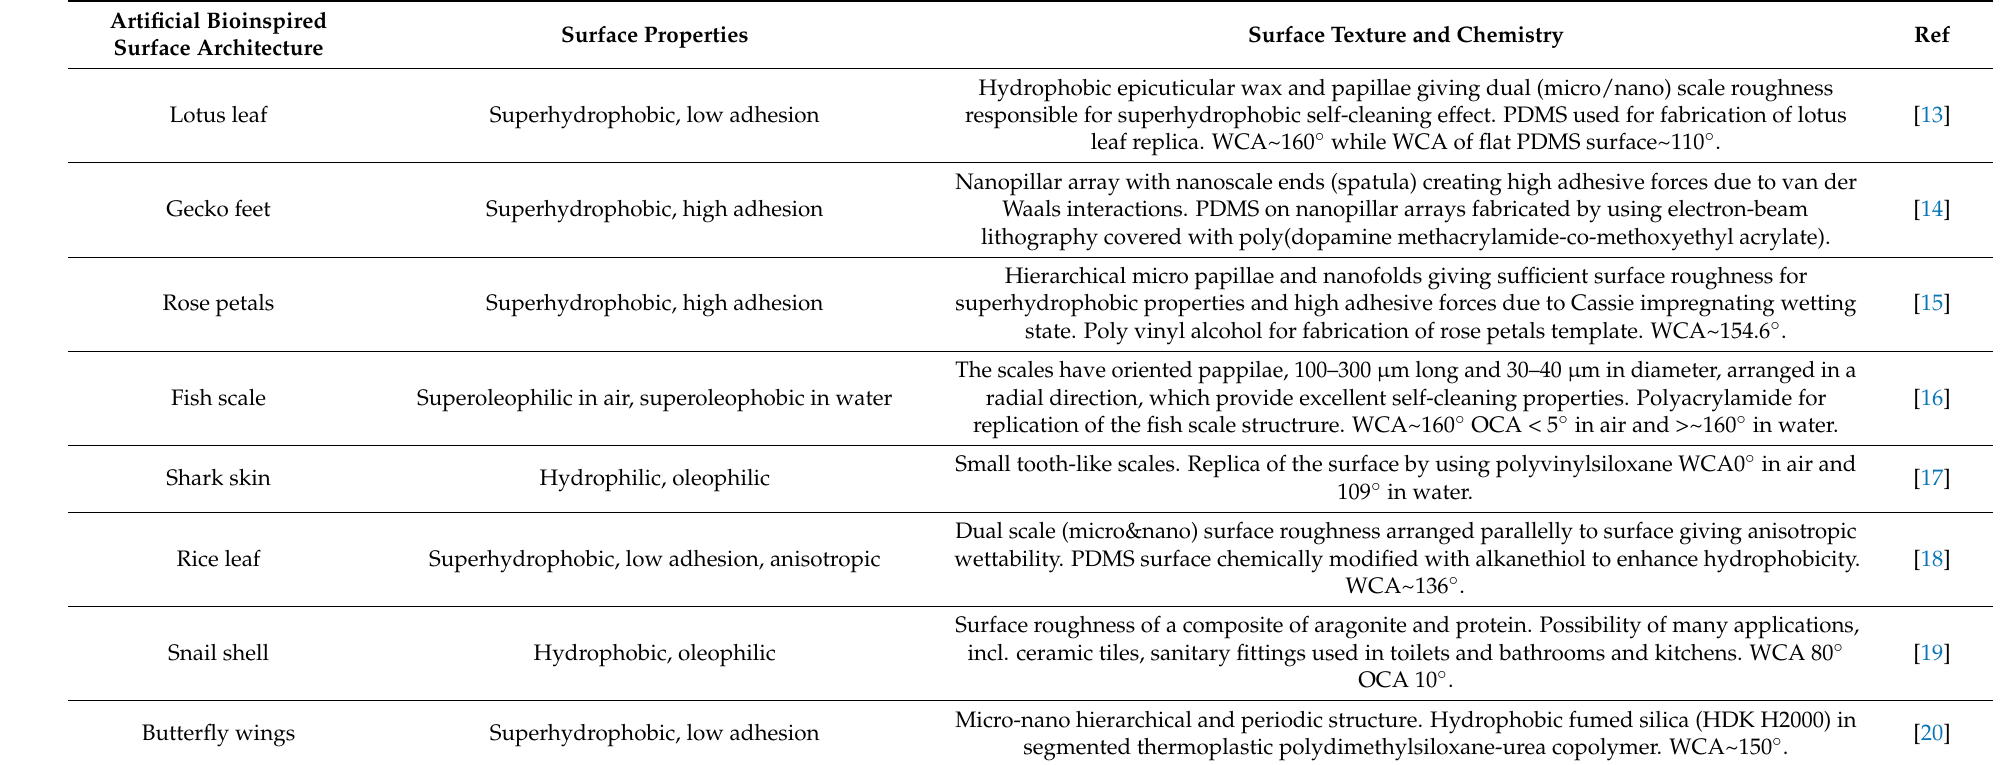
Table 1. An overview of such self-cleaning